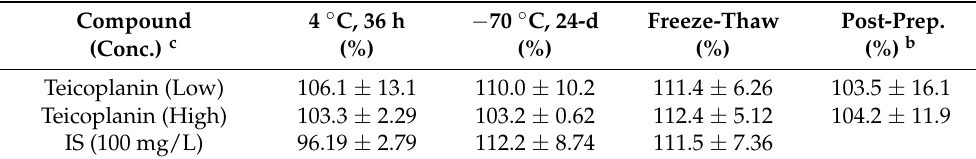
Table 2. Stability of teicoplanin and IS ( n = 3) a